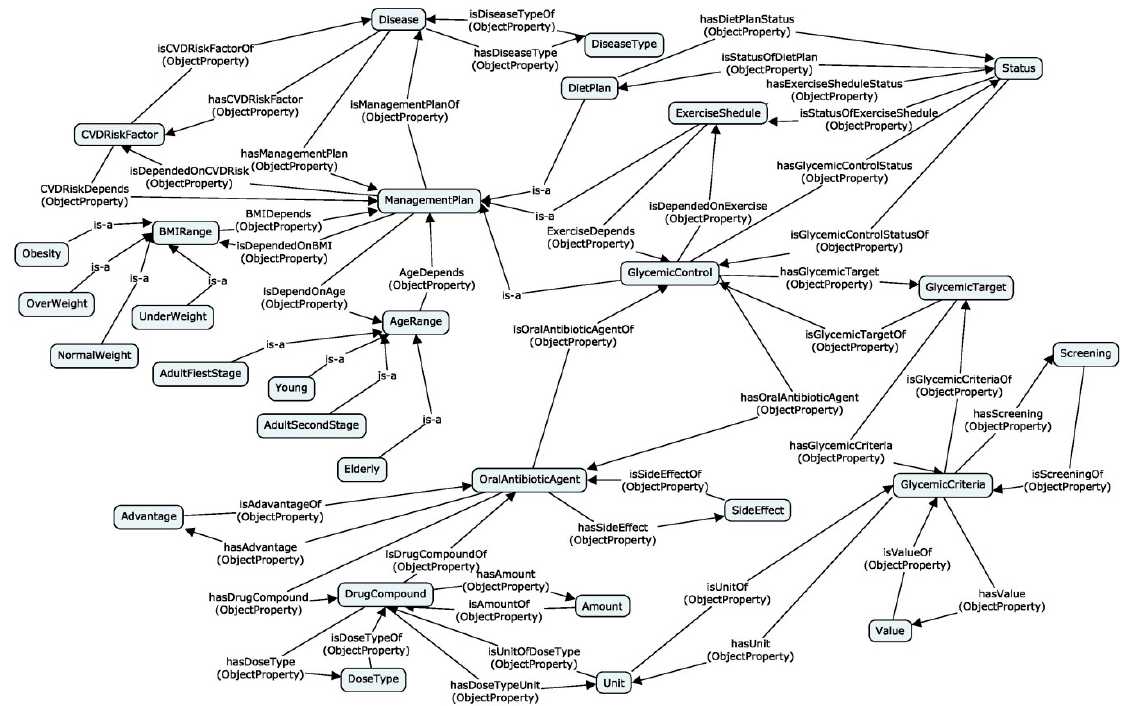
Figure 7. Ontology structure for motivation scenario